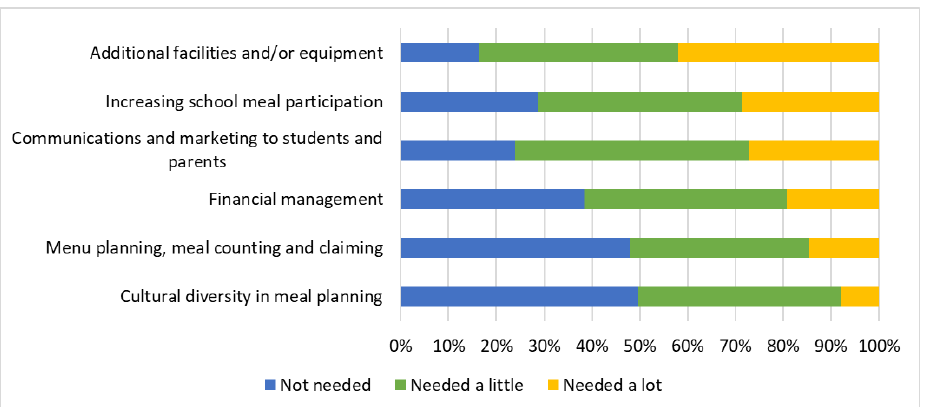
Figure 7. Additional resources or information needed by the Californian school food authorities to implement universal school meals in the SY 2022 – 23 ( n = 572 to 577 depending on missingness of